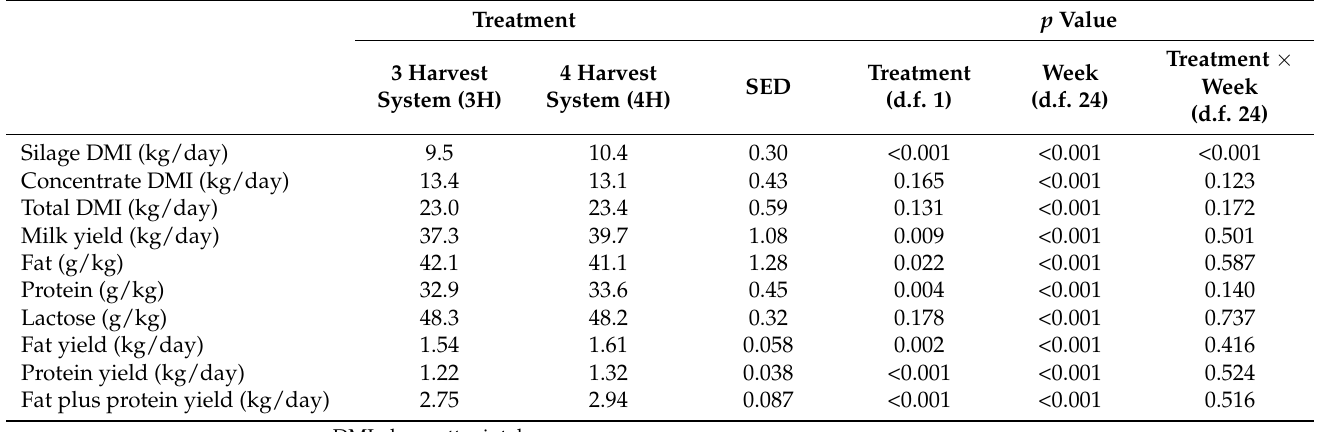
Table 3. Effect of offering silage made within either a three- (3H) or four-harvest (4H) system on average daily intakes, milk production and milk composition across all harvests.